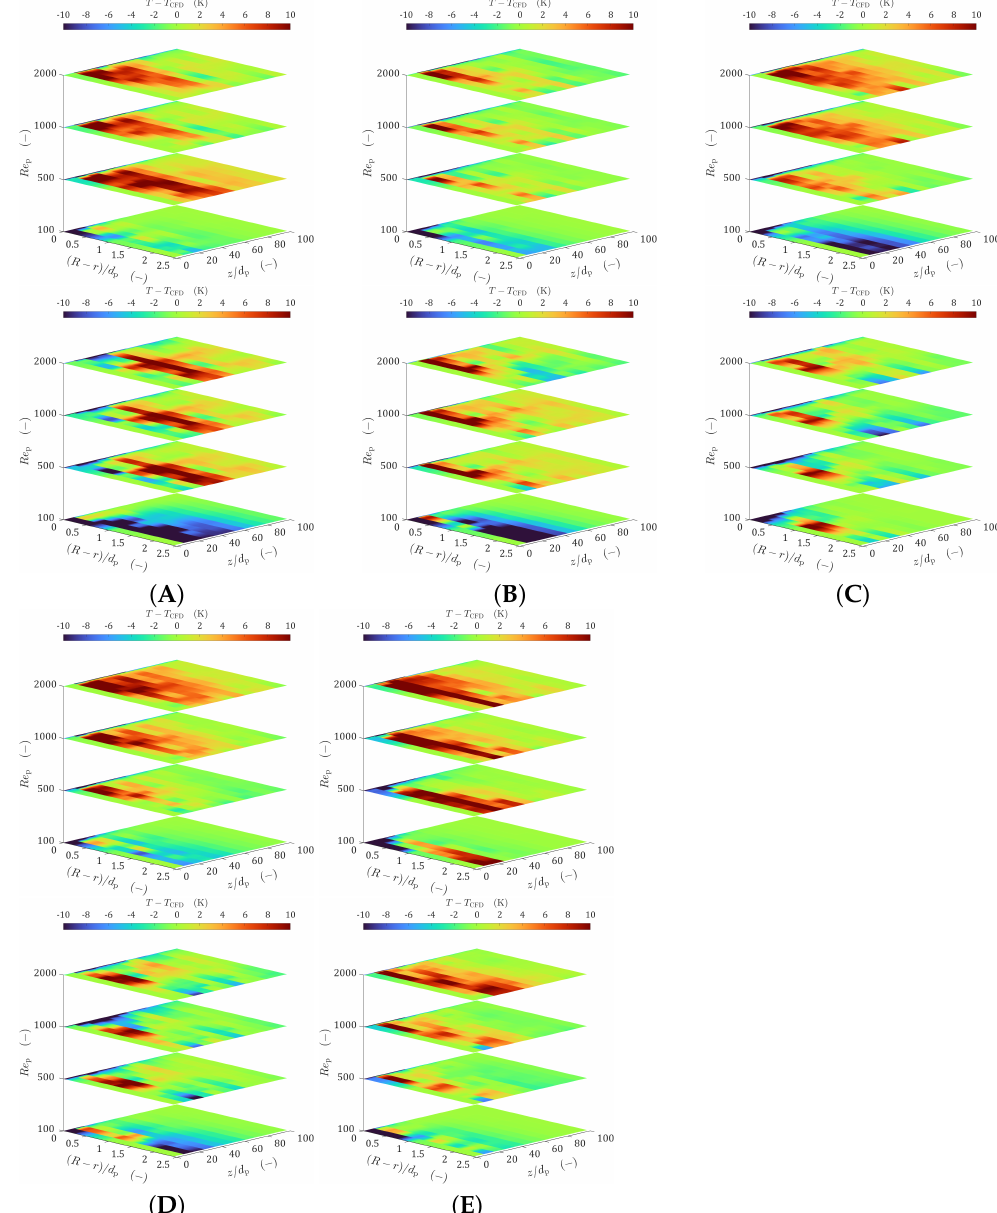
Figure 9. Deviation of the λ eff,r - α w model results in comparison to particle-resolved CFD data, for loose (top) and dense (bottom) packings of ( A ) spheres, ( B ) cylinders, ( C ) rings, ( D ) four-hole cylinders, and ( E ) spheres with the wall